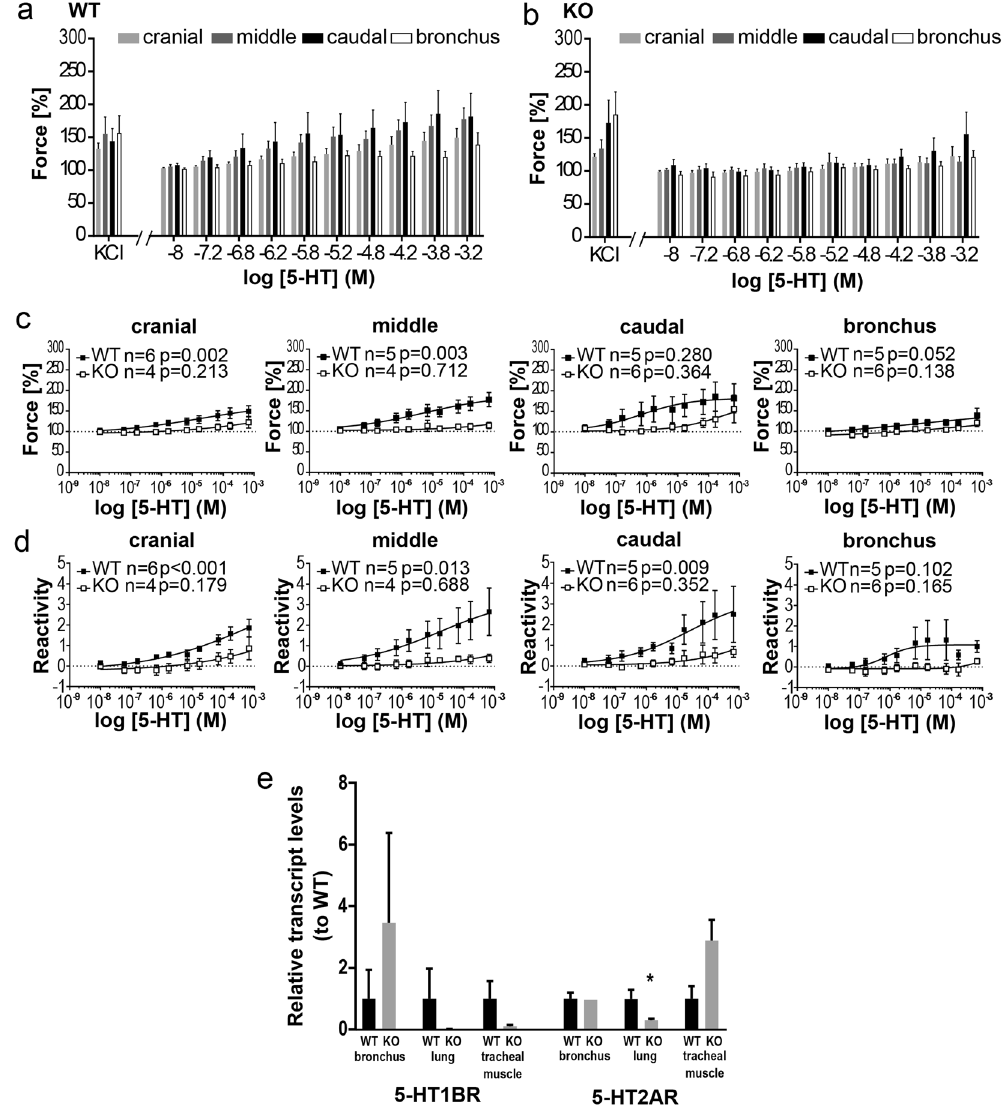
Figure 6. Changes in constrictor force and reactivity of various extrapulmonary airway segments from cav- 3 + / + (WT) and cav-3 − / − (KO) mice induced by 5-HT. In the organ bath recordings, each point represents the mean number of animals (n) ± SEM. After equilibration, baseline tension was adjusted to 0.5 g. Baseline was set as 100% and the maximum response at each concentration was calculated. ( a , b ) Changes in constrictor force after additive application of 5-HT. 5-HT induces concentration-dependent contraction in the cranial and middle part of trachea from cav-3 + / + mice, whereas the trachea of cav-3 − / − mice and the extrapulmonary bronchi are not responsive to 5-HT. ( c , d ) Comparison of constrictor response (force and reactivity) between both mouse strains. Cav-3 + / + mice showed significant constriction in the cranial and middle part of the trachea, whereas there was no significant constriction in the caudal part and the extrapulmonary bronchi. In contrast to this neither the tracheal segments nor the extrapulmonary bronchi constricted in cav3 − / − mice. All tracheal segments of cav3 + / + mice showed a significant reactivity, whereas the reactivity of the extrapulmonary bronchi was not significant. Reactivity was abolished in cav-3 − / − mice. Data were analyzed with One-Way ANOVA or the Kruskal-Wallis test followed by Dunnett’s test for multiple comparisons, depending on normal distribution established with the Shapiro-Wilk normality test. ( e ) Relative transcript levels of 5-HT1BR and 5-HT2AR genes standardized on internal β -microglobulin ( β -MG) levels. Results for the cav-3 − / − tissues are presented relative to the results for cav-3 + / + tissues set to 1 to appreciate its potential differences independent from individual assay performance. Data are presented as mean ± SEM (Student’s t-test, * p < 0.05; n = 4 mice per